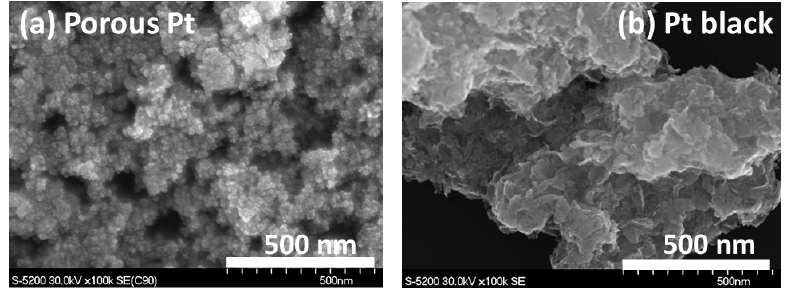
Figure 2. SEM images of ( a ) porous Pt and ( b ) Pt black.